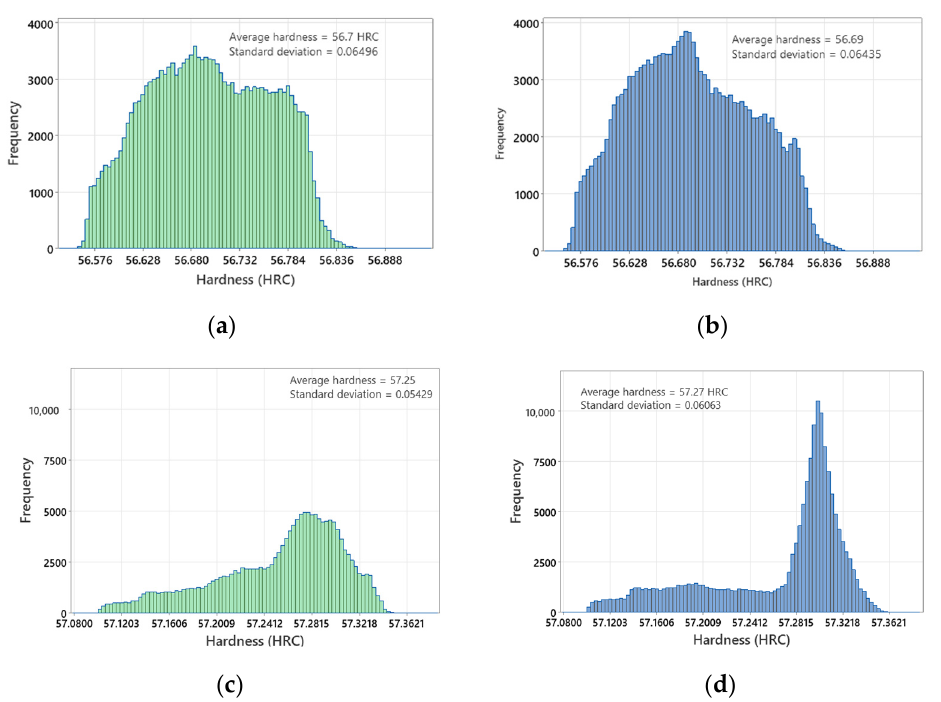
Figure 12. Nodal hardness distribution in entire FEM model: ( a ) V-OQ; ( b ) H-OQ; ( c ) V-WQ; and ( d ) H-WQ.